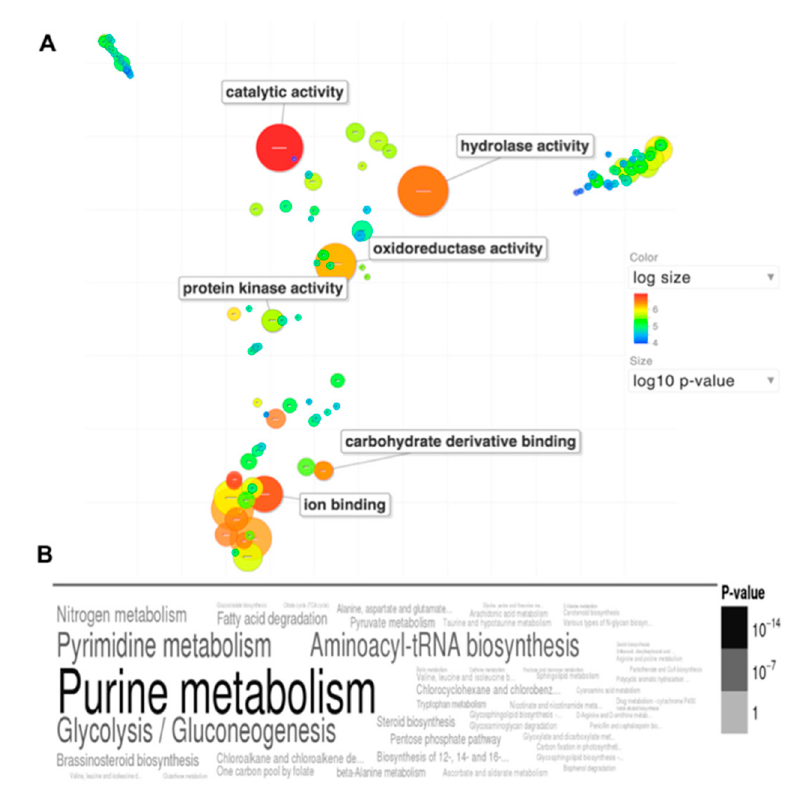
Figure 14. Gene ontology enrichment analysis of the 27 biomarker candidates indicates enriched hydrolase activity and increased purine and carbohydrate metabolism functions. ( A ) Scatterplot of gene ontology enrichment of molecular functions, with size of the circles is proportional to the significance of enrichment. ( B ) Word cloud of enriched KEGG metabolic pathways. Size of the words indicates the significance of enrichment. Figures were produced using Revigo and GOSummaries. The figure is from [77,78] .